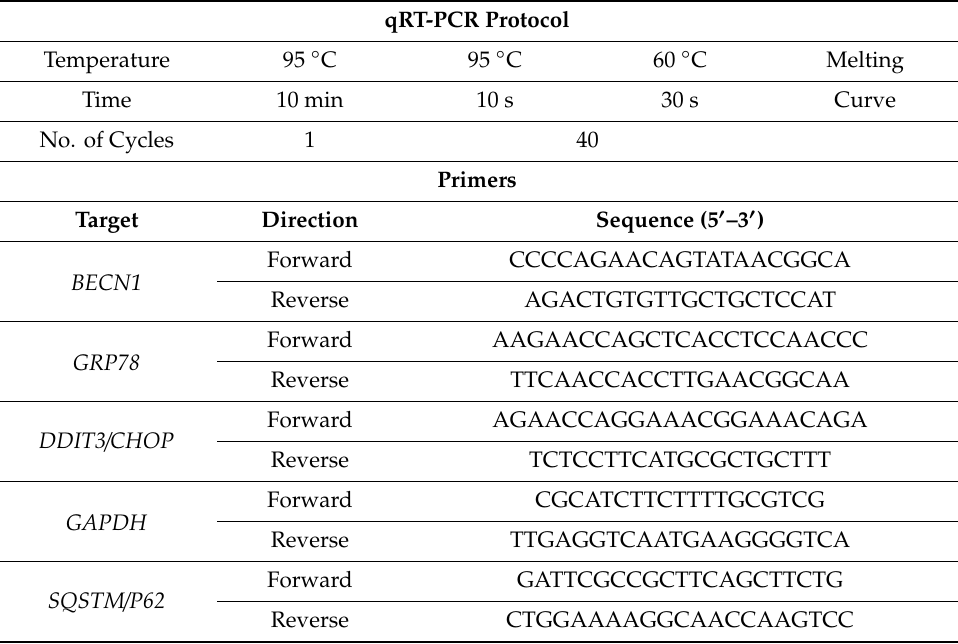
Table 1. Protocol details and primer